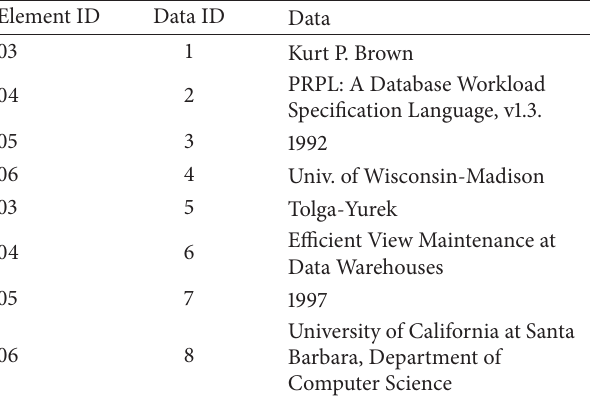
Table 1: Snippet of Element Data Table for